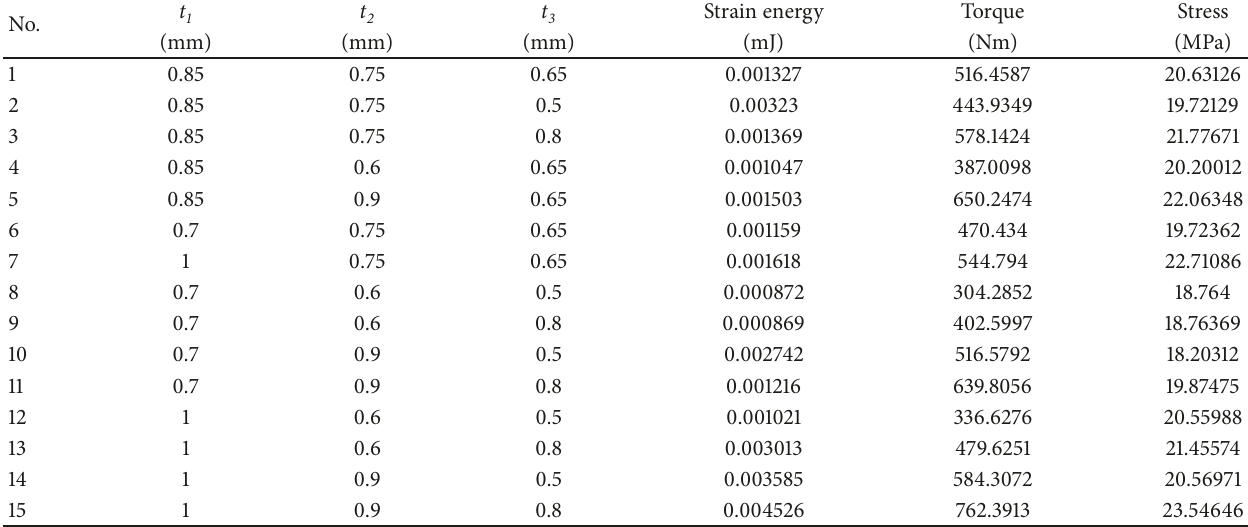
Table 3: Design of experiments and numerical data.